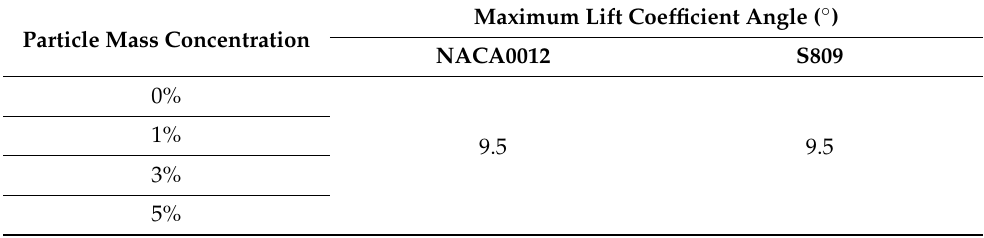
Table 4. Angles of attack, at which the maximum lift coefficient is obtained, for Case 4.